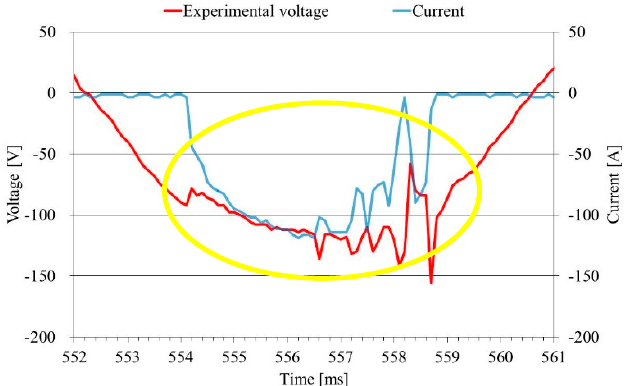
Figure 16. Magnified view of the part surrounded by a green ellipsoid in Figure 15.